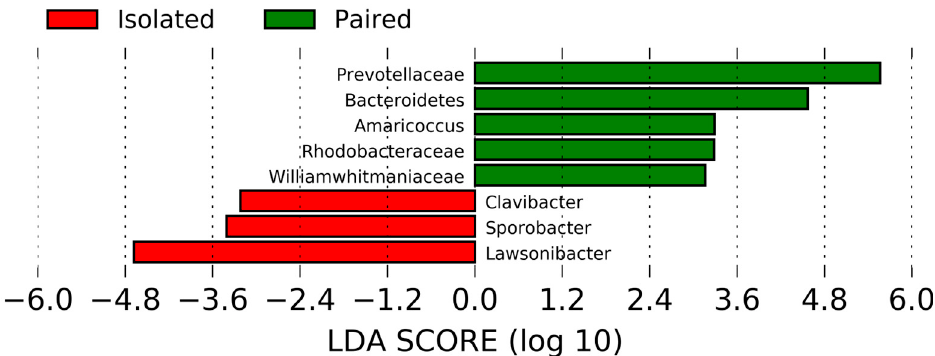
Figure 5. LEfSe analyses demonstrated differential abundance of microbial community members in colons of paired (N = 11) and isolated voles (N = 11). Bacteroidetes, Prevotellaceae , Rhodobacteraceae , Williamwhitmaniaceae , and Amaricoccus exhibited a greater abundance in paired voles and Clavibacter , Sporobacter , and Lawsonibacter in isolated voles.